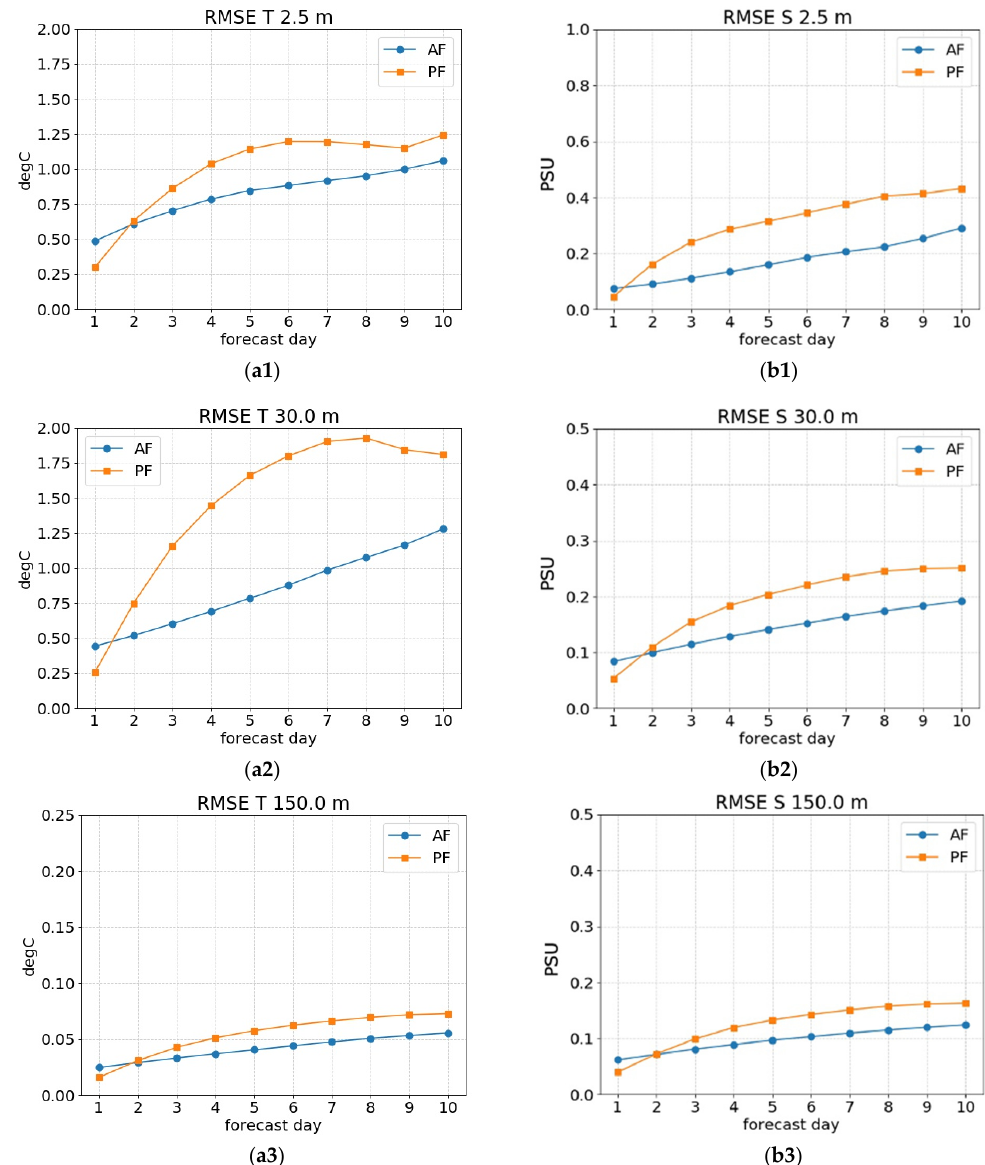
Figure 7. RMS of 𝐴𝐹 (Analysis-Forecast, in blue), 𝑃𝐹 (Forecast-Persistence, in orange) for temper- Figure 7. RMS of AF (Analysis-Forecast, in blue), PF (Forecast-Persistence, in orange) for temperature ature (on the left, ( a1 – a3 ), expressed in °C) and salinity (on the right, ( b1 – b3 ), expressed in PSU) at (on the left, ( a1 – a3 ), expressed in ◦ C) and salinity (on the right, ( b1 – b3 ), expressed in PSU) at 2.5 m 2.5 m (1), 30.0 m (2) and 150 m (3), computed for August 2020. (1), 30.0 m (2) and 150 m (3), computed for August